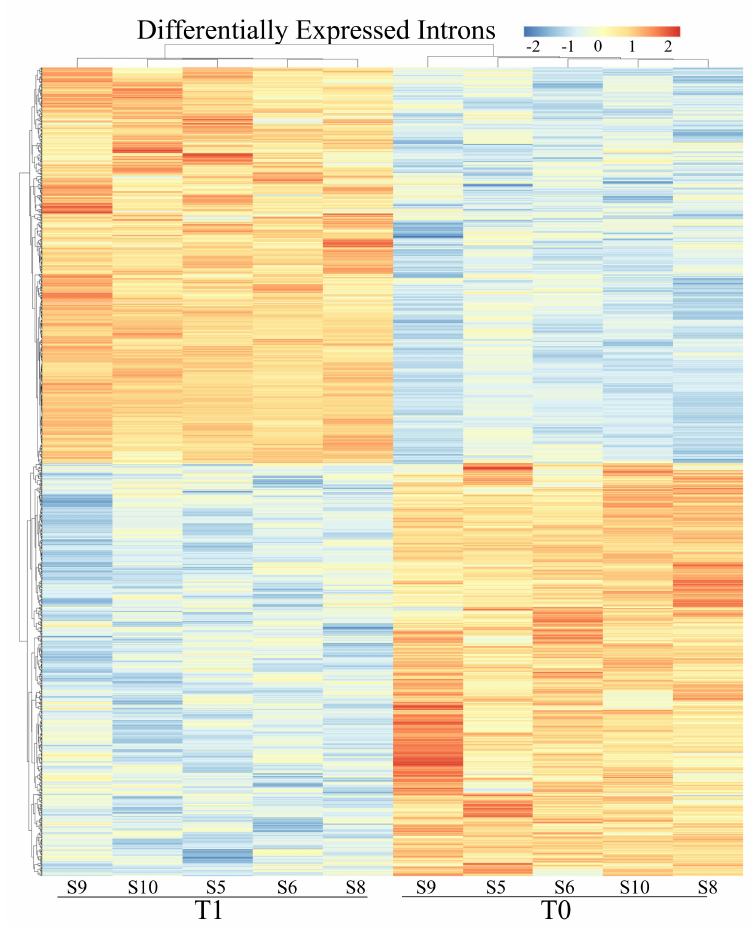
Figure 3. Heat maps of di ff erentially expressed genes basing on intron counts. Like for the DEGs for the exonic compartment, also in this case there is a clear sample clustering in the two biological conditions. Legend above displays range of